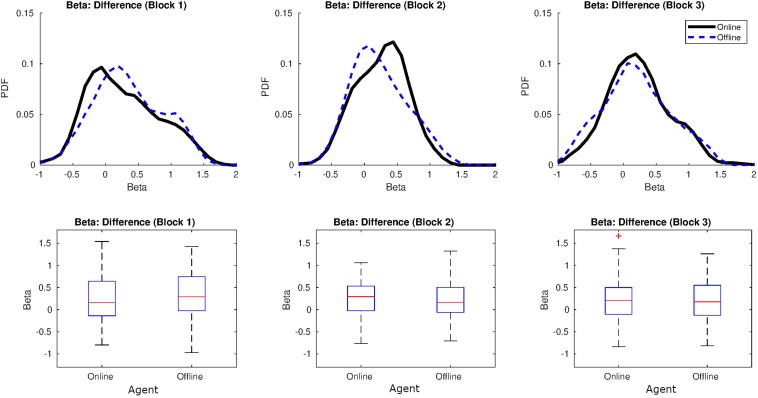
Distribution of β in Study 2. At the top: distributions for the values of β (in black online agent, in blue offline agent). At the bottom, representation of the means and variances as boxplots.